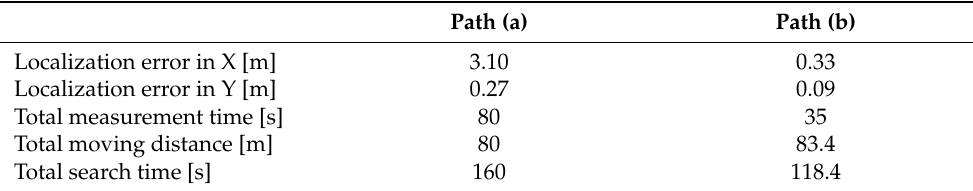
Table 2. Performance comparison of two